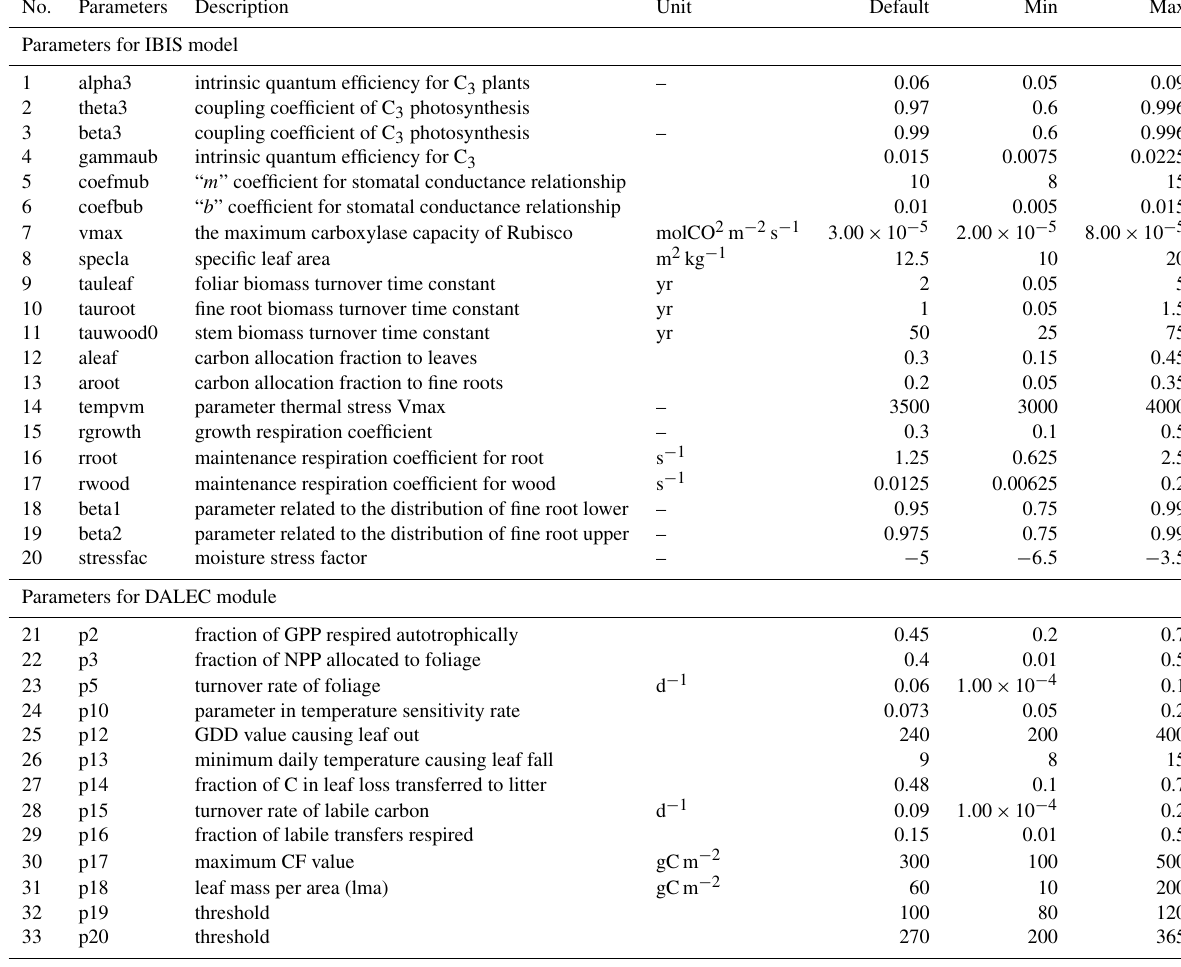
Table 2. Description and prior ranges of IBIS–DALEC